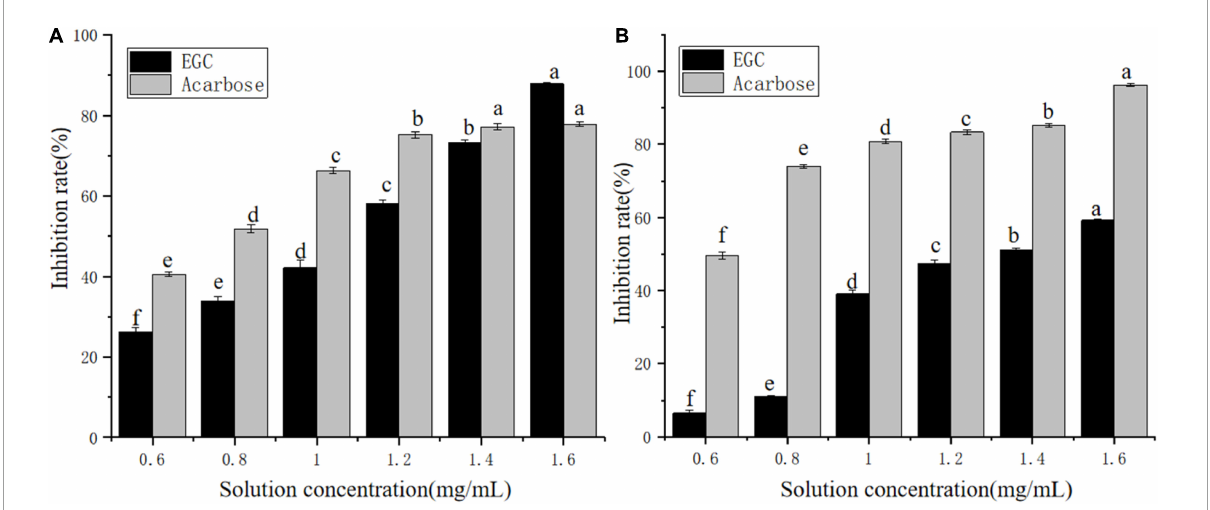
FIGURE2 Inhibition effects of epigallocatechin on α -glucosidase (A) and α -amylase (B) (error bars represent standard deviation and different letters indicate significant differences at p < 0.05).